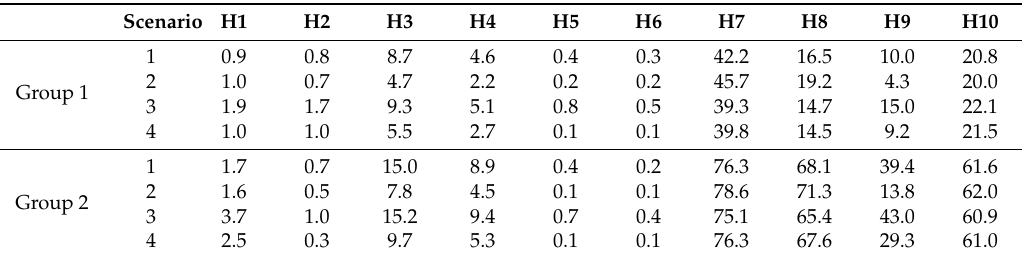
Table 9. Performances (RPD) of heuristics by group and scenario in relation to EM for Group 1 and to the best found solution for Group